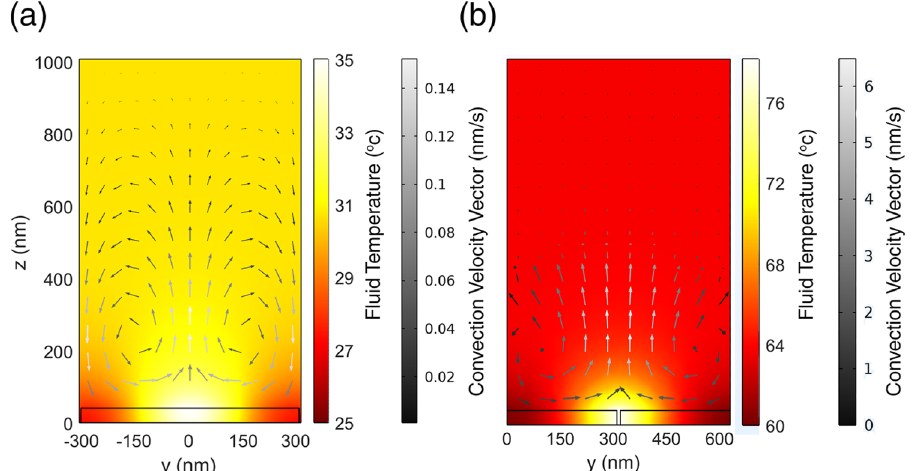
Figure 10. Temperature distribution and the fluidic convection velocity vectors (arrows) in the surrounding aqua medium, when ( a ) LSPMs, and ( b ) DSPMs are excited by the incident power densities of 7.7 mW μm −2 and 83 mW μm −2 ,